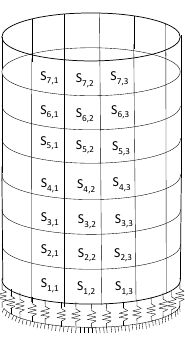
Figure 20. Finite element model of the cylindrical tank.